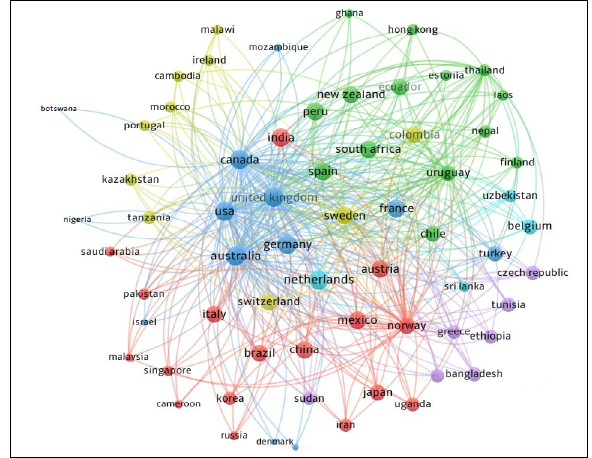
Figure 3: Countries’ network collaboration at the global